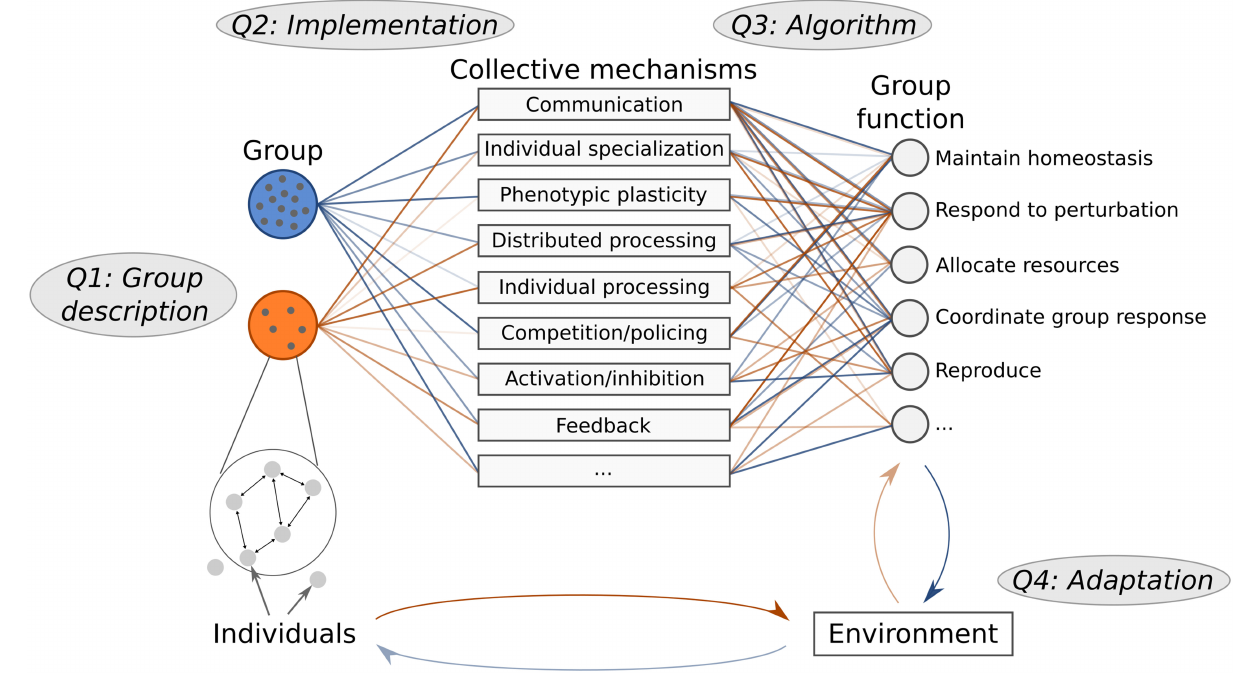
FIGURE 1 | Collective mechanisms link individual to group function. Different groups have different structures, and may use a different set of mechanisms to perform similar functions. The way mechanisms are implemented depends on the constraints and structure of the individuals in a particular group, and thus some groups may be more effective than others at implementing certain mechanisms. Differences between groups are illustrated by the connections and the transparency of the lines linking groups to each collective mechanism. To compare collective behavior in different systems, we use complementary questions: how groups are structured (Q1), how individual behavior is used to implement certain collective mechanisms (Q2), how multiple collective mechanisms contribute to group function (Q3), and how both individual and group behavioral algorithms are adapted to the particular environment